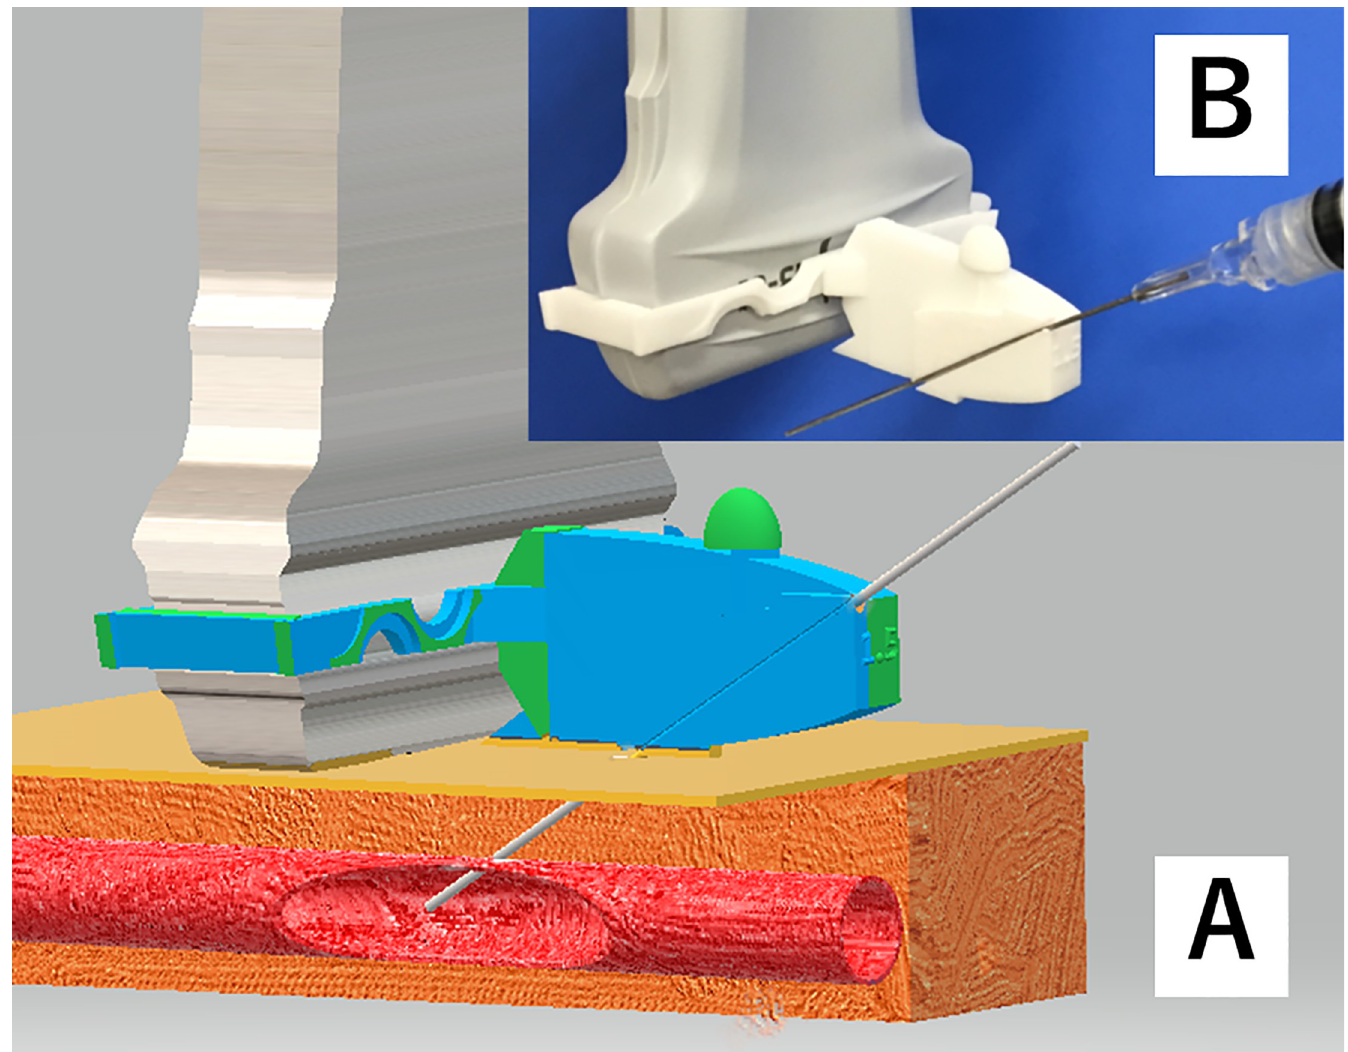
Fig 2. Novel needle guide with a shallow angle of approach. Panel A: Design of the novel needle guide using 3D Builder. Panel B: The needle guide is created using a 3D printing service and is made of nylon.